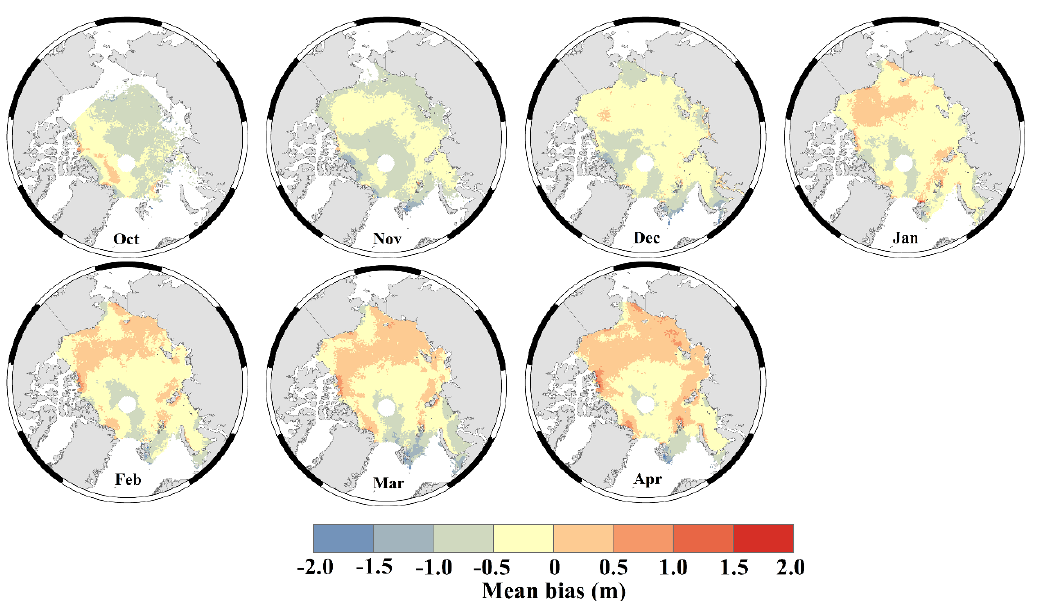
Figure 3. The mean bias maps (PIOMAS–CS2) between PIOMAS and CS2 during the sea ice growth season in 2010–2019.